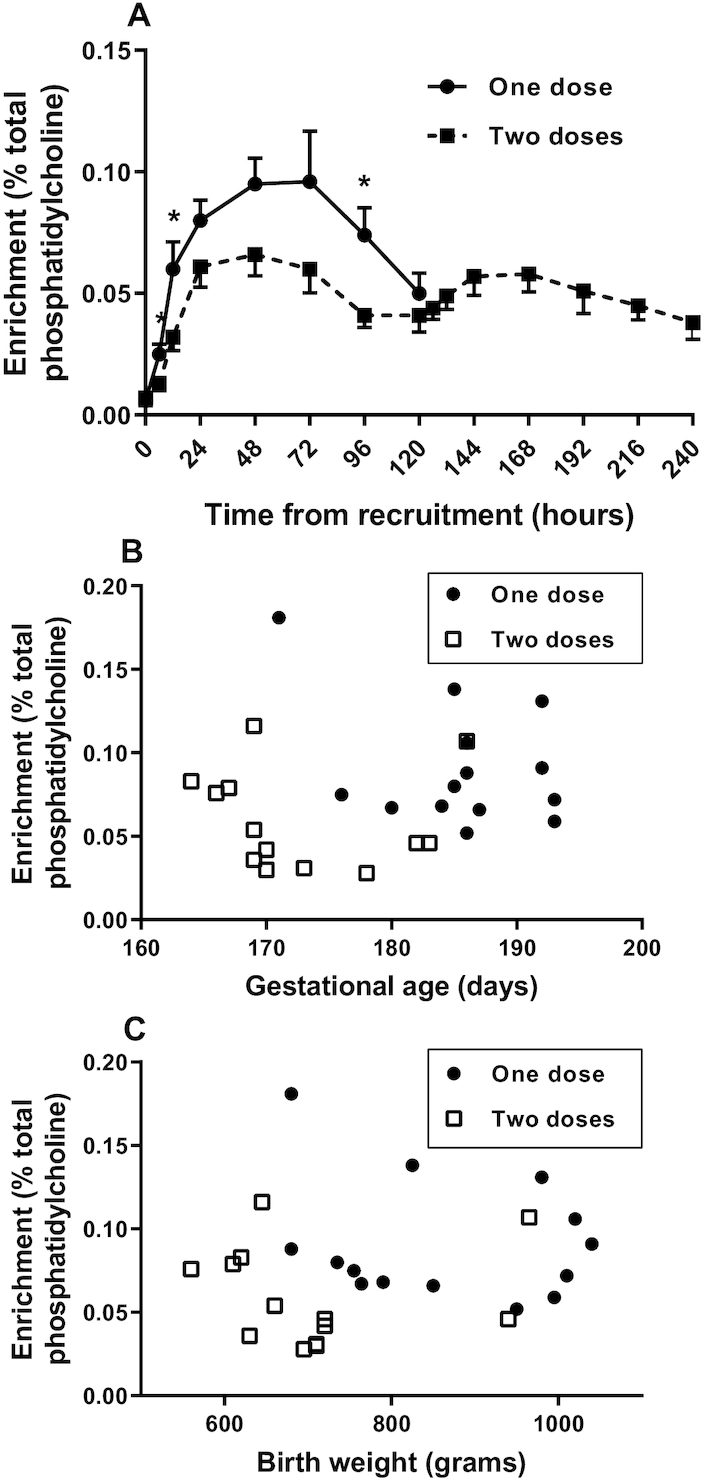
The effect of disease severity and immaturity on label incorporation into PC molecular species by the PEMT pathway. Combined enrichments of the polyunsaturated species PC 38:4, PC 38:5, PC 38:6, and PC 40:6 were calculated in panel A for infants with more severe disease who received a second dose of methyl-D9-choline at 120 h compared with infants who received a single dose of label (mean ± SEM; *P < 0.05, t test). Initially, 14 infants received the single dose and 13 infants received 2 doses. Corresponding numbers at 120 h were 6 and 11 infants. Infants with too few samples to calculate label incorporation (n = 4) were excluded. The association of PEMT, calculated from methyl-D3 label enrichment at 24 and 48 h, is shown for gestational age (B) and birth weight (C). PC, phosphatidylcholine; PEMT, phosphatidylethanolamine N-methyltransferase.